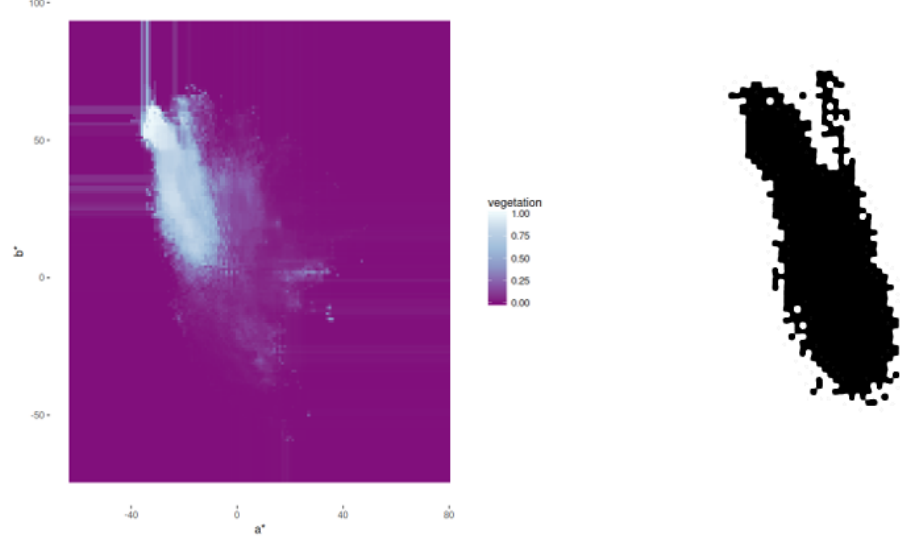
Figure 5. Random Forest segmentation. Using a a ∗ b ∗ space ( left ), a random forest classifier is trained to predict green space (area above 0.32), generating a bitmap mask ( right ). A pixel is then classified as vegetation if its a ∗ b ∗ colour coordinates are contained within the